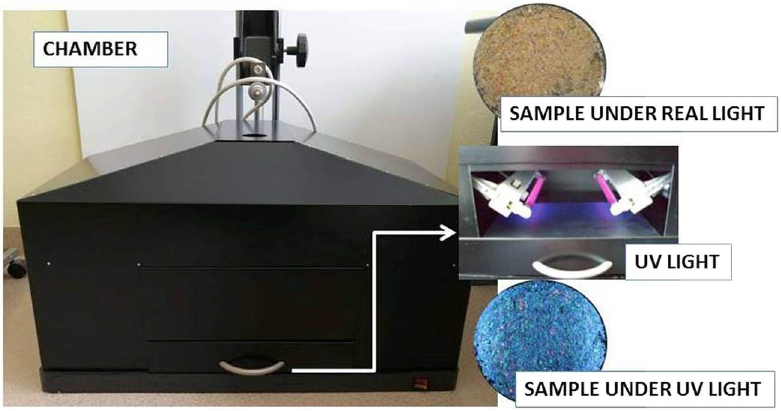
Figure 1: Schematic representation of the setup of the optical fl uorescent method.